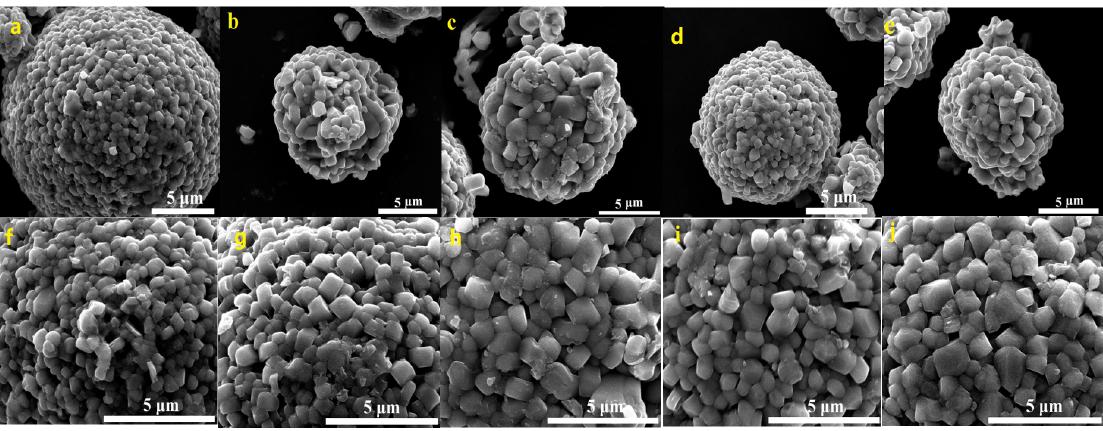
Figure 3. XRD patterns of Li[Ni 0.6 Co 0.2 Mn 0.2 ] 1-x Ga x O 2 samples.